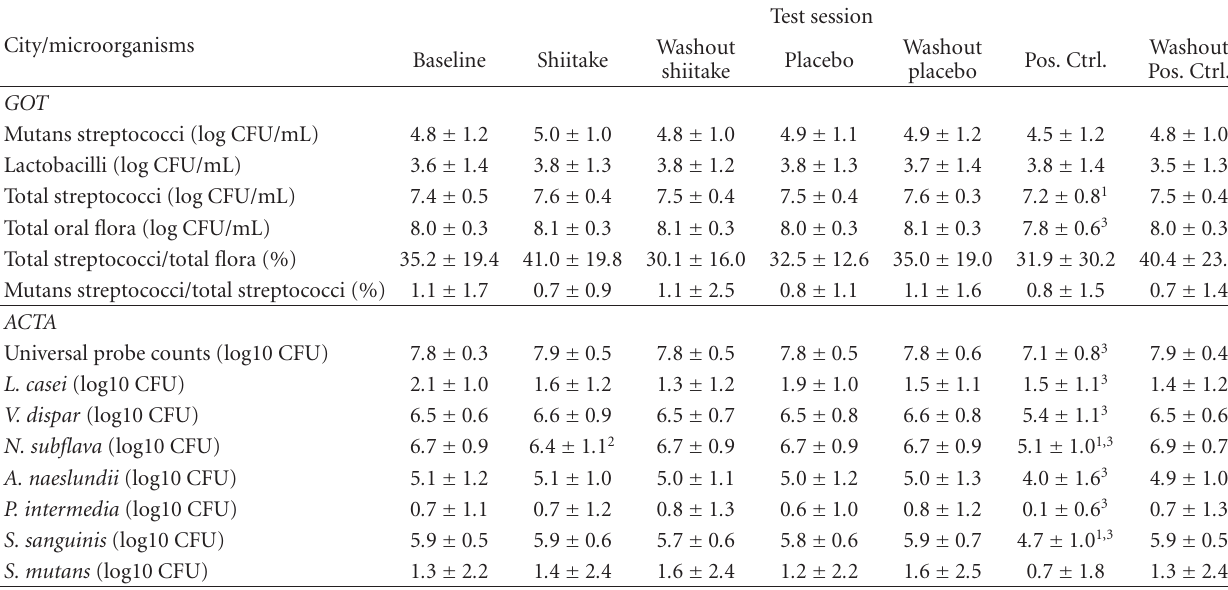
Table 1: Number of salivary and plaque microorganisms and proportions of microorganisms after baseline, the three test periods (shiitake, placebo, positive control (AmF-SnF 2 ; Pos Ctrl)) and three washout periods (washout shiitake, washout placebo, and washout positive con- trol) for GOT ( n = 30) and ACTA ( n = 35). Mean ± SD.